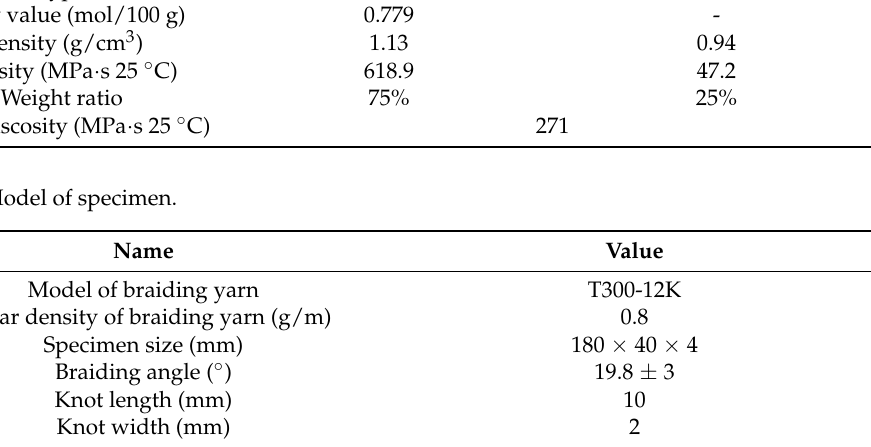
Table 1. Proportion and viscosity of resin system.